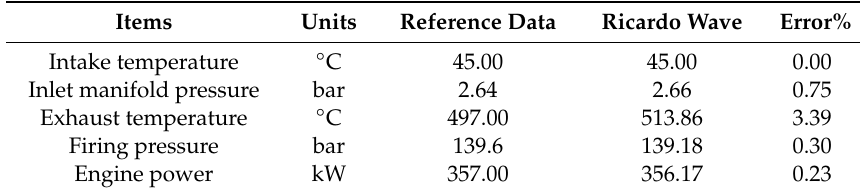
Table 4. Comparison between reference data and calculated results from Ricardo Wave at 75% engine load.